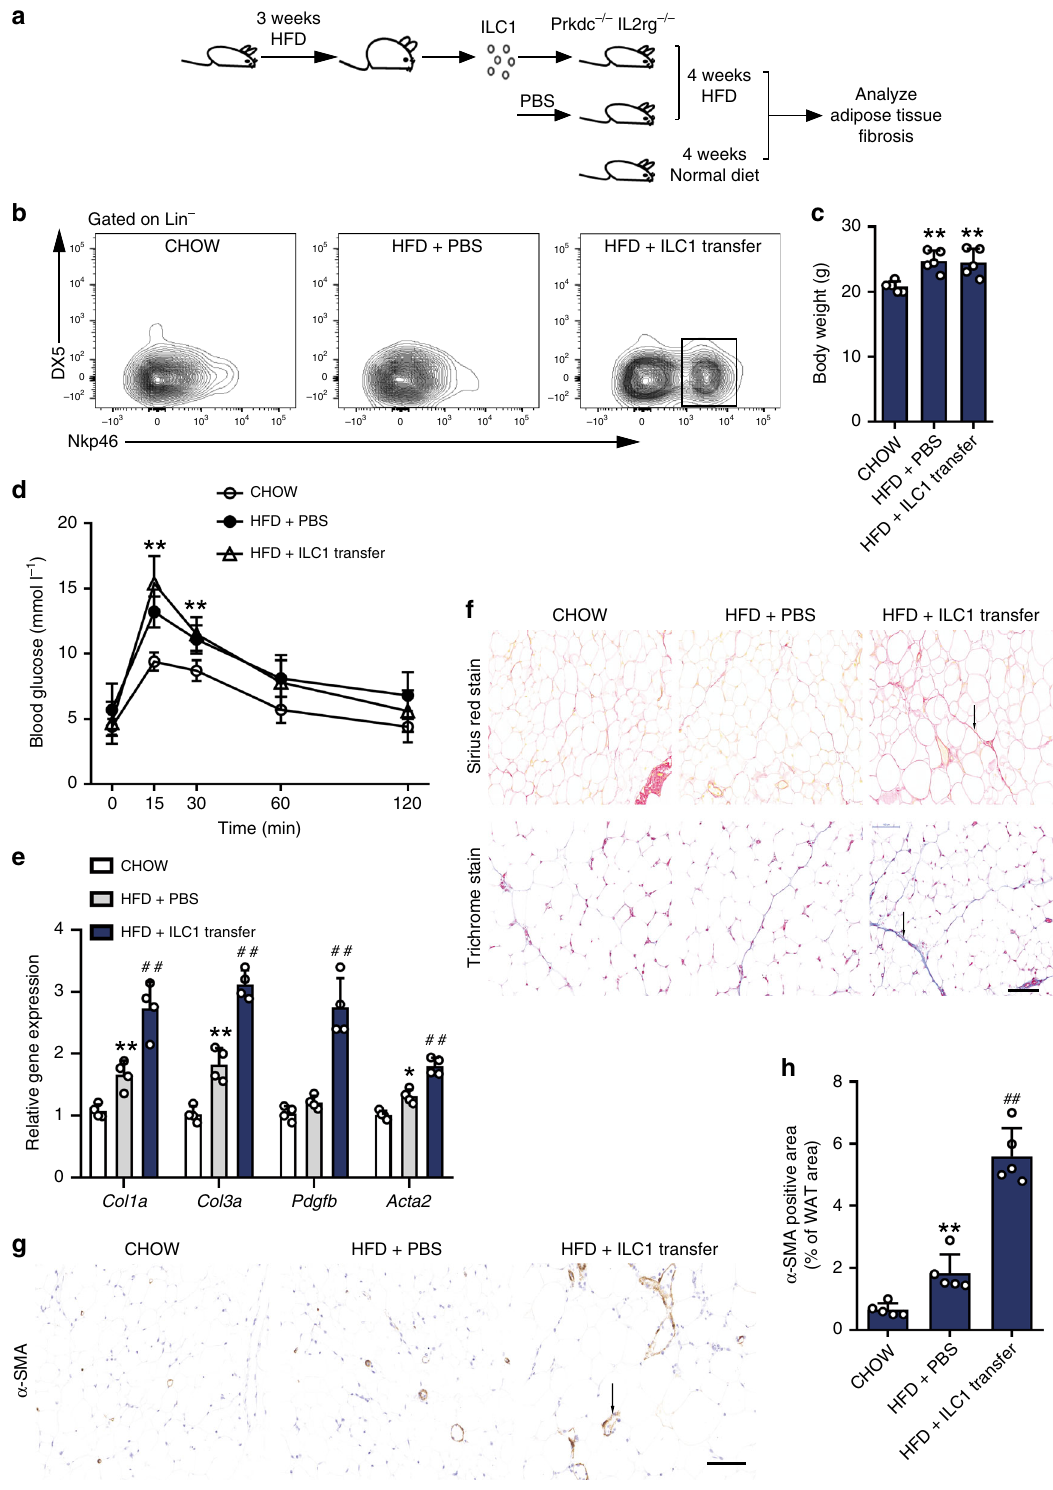
Fig. 3 Adipose ILC1s contribute to obesity-associated adipose fi brosis. Brie fl y, C57BL/6 mice were fed a HFD for 3 weeks, and 5 × 10 4 adipose ILC1s were sorted (>95% purity) from adipose tissue and adoptively transferred intravenously (i.v.) into Prkdc − / − IL2rg − / − mice. The recipient mice were fed a HFD for 4 weeks. a Schematic of the experiment. b Representative plots indicate adoptively transferred adipose ILC1s in the VAT of recipient mice 4 weeks after transfer. c Body weight. d Glucose tolerance test. e Expression levels of fi brosis-related genes, assessed by q-PCR. f Representative Masson ’ s trichrome C and Sirius red staining in VAT of mice with different treatment (scale bar: 100 μ m). g , h Representative α SMA staining (scale bar: 100 μ m) and quanti fi cation of α SMA-positive area in VAT of mice with different treatment. Arrows indicate positive staining areas. * P < 0.05 vs. CHOW group; ** P < 0.01 vs. CHOW group; ## P < 0.01 vs. HFD + PBS group (two-way ANOVA tests followed by Bonferroni post hoc test). The data are representative of three independent experiments, with n = 4 – 6 mice per group. Error bars indicate